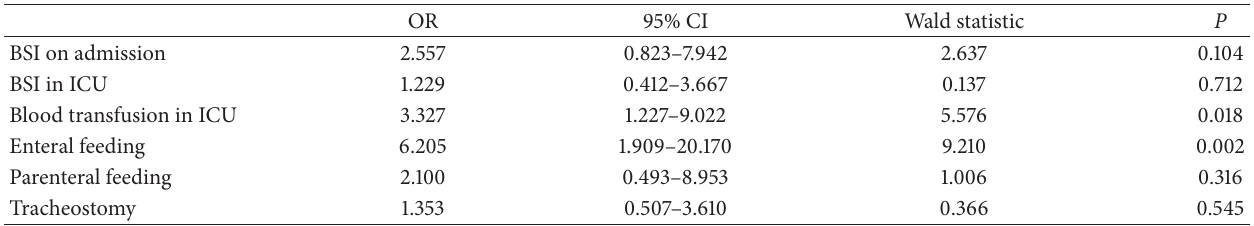
Table 4: Multivariate analysis for risk factors for ventilator-associated pneumonia (VAP) in all analyzed